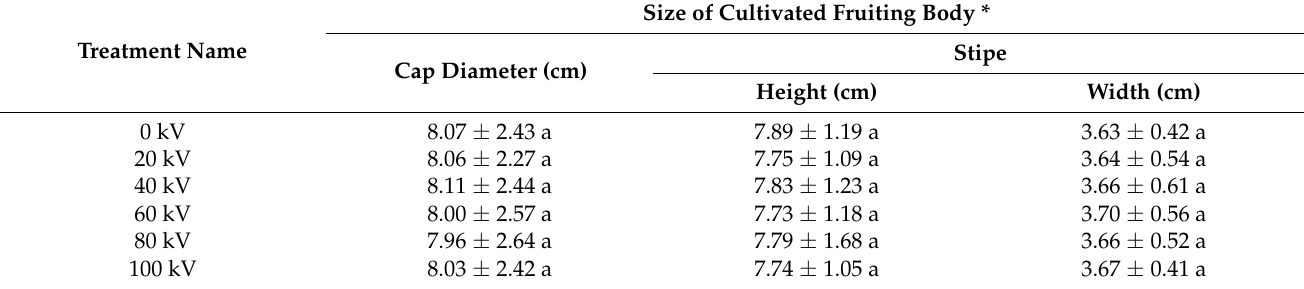
Table 3. Fruiting body size of P. spongiosus resulting from the cultivation process and high-voltage pulsed